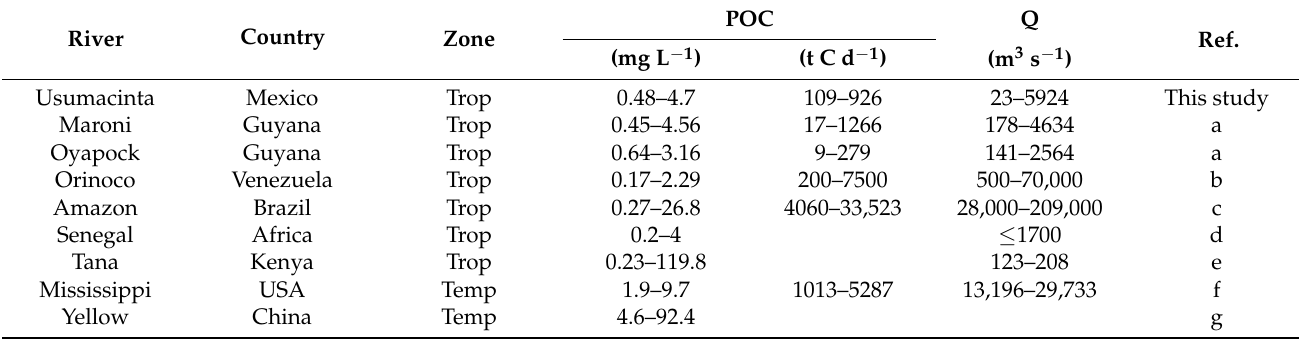
Table 4. Water discharge (Q), POC concentrations, and flux of some rivers in the